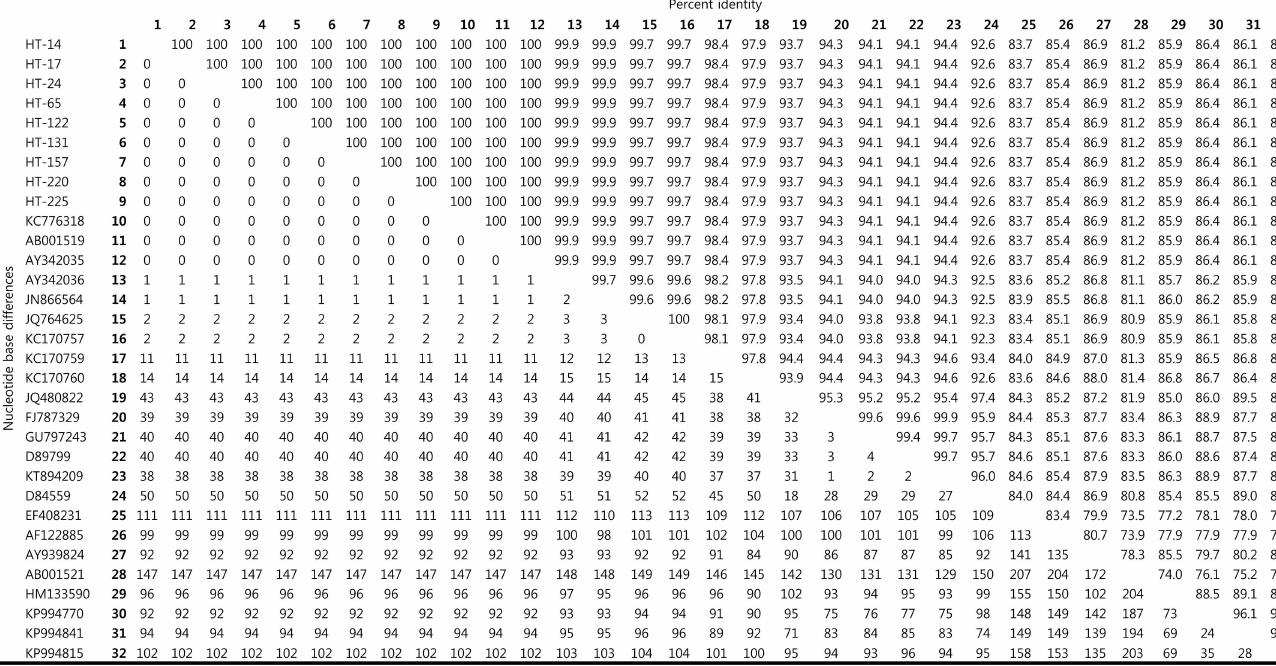
PLOS ONE | DOI:10.1371/journal.pone.0165784 October 28,